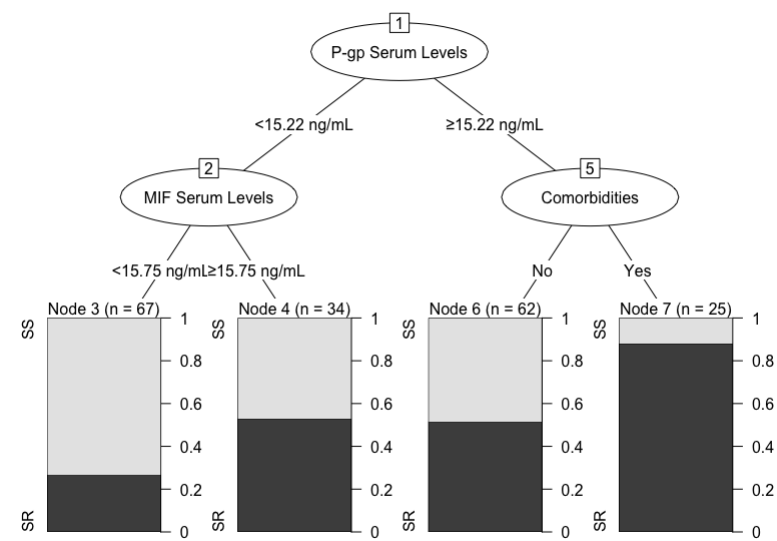
Figure 2. CHAID decision